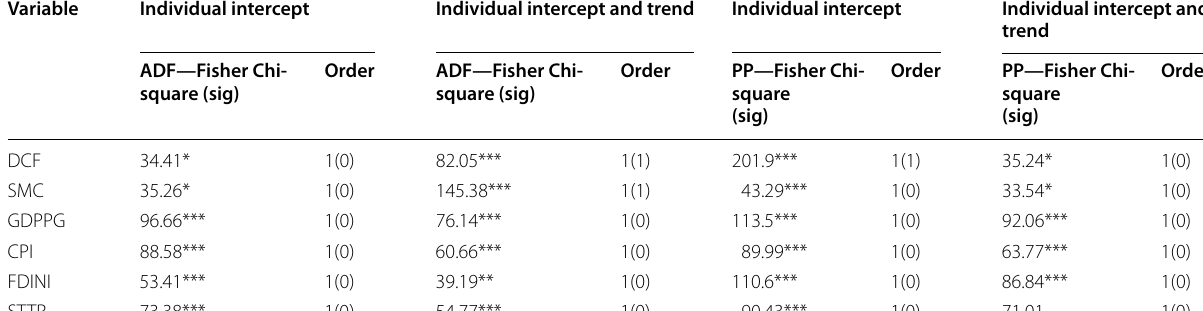
Table 3 Augmented Dickey–Fuller and Phillips – Perron tests are a unit root test . Source: Software of E-views 10 output